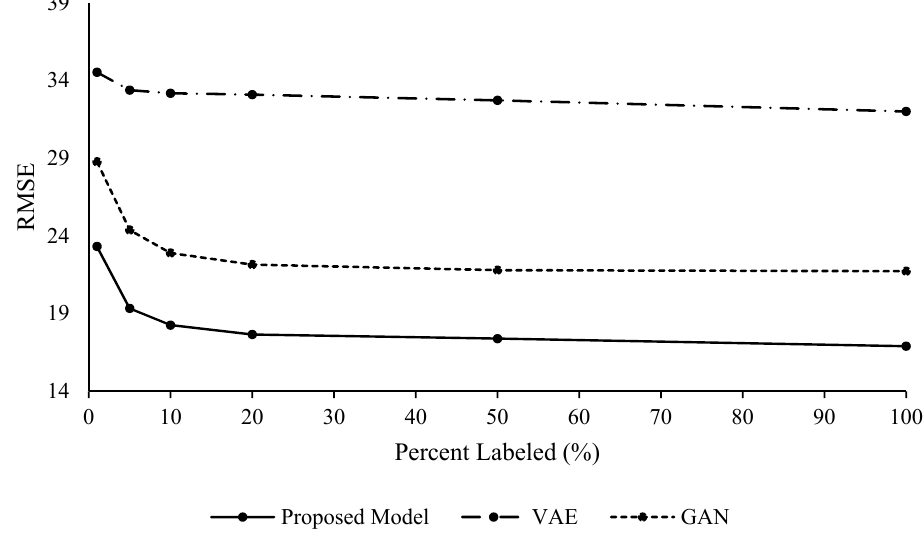
Figure 12. FD001 Unsupervised Feature Learning, Random Labeling Intervals.